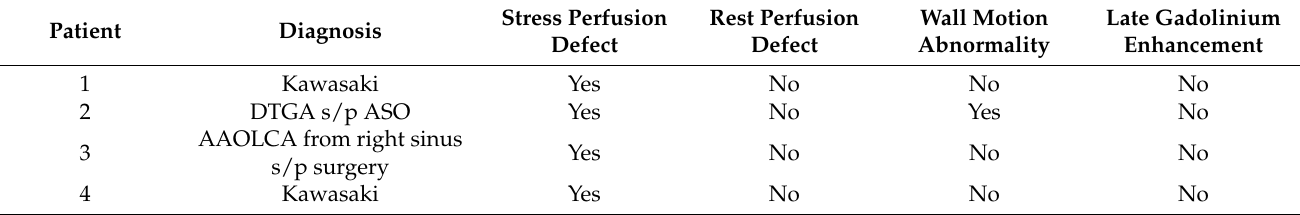
Table 2. Clinical diagnosis of 4 patients with reversible perfusion deficits.